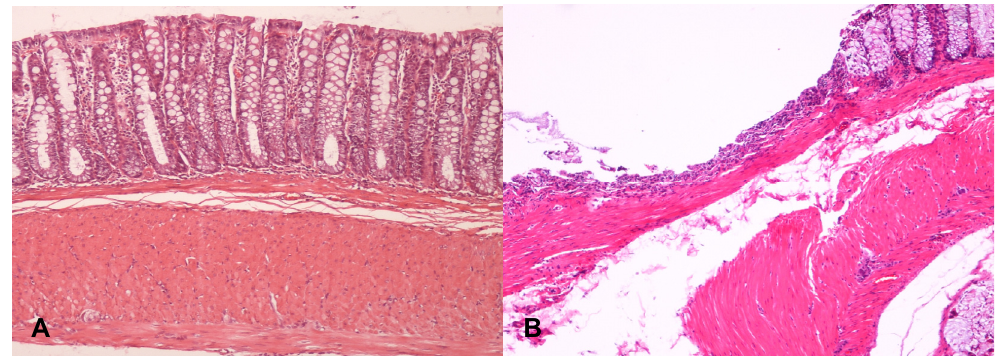
A B FIGURE 7 - Characteristics of the intestinal mucosal surface, in the segments with and without transit. A- Mucosal surface in the colon with intestinal transit. B- Deep ulcer in the mucosal surface of the colon without intestinal transit (H.E – 200x)